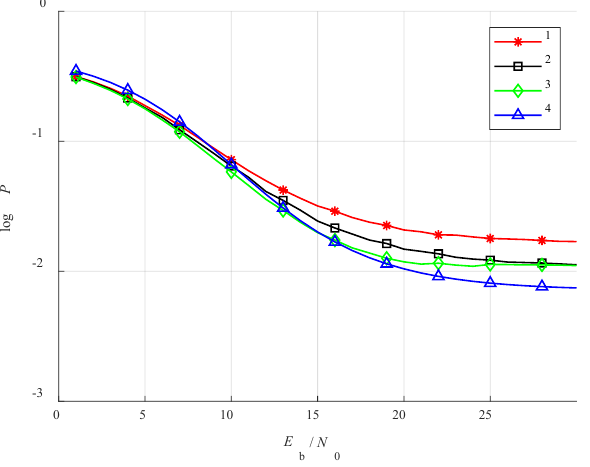
Figure 8. Bit error probability as a function of E b / N 0 at the processing gain K = 15. Curve 1 corresponds to simulation with a Gaussian distribution, 2—uniform distribution, 3—telegraph distribution, and curve 4—analytical estimate.